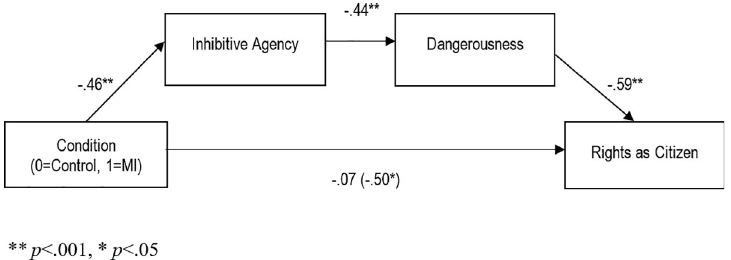
Fig 3. Indirect effect model of using the defense of mental impairment on rights as citizen, via inhibitive agency and dangerousness. Path values are expressed in unstandardized coefficients.